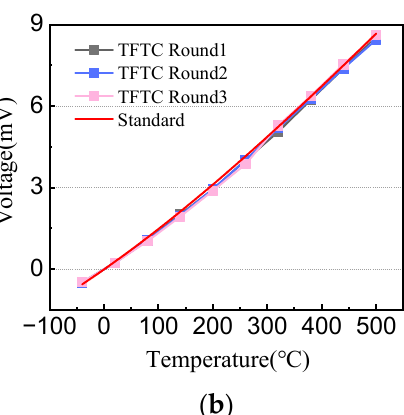
Figure 5. The response time of the TFTCs.